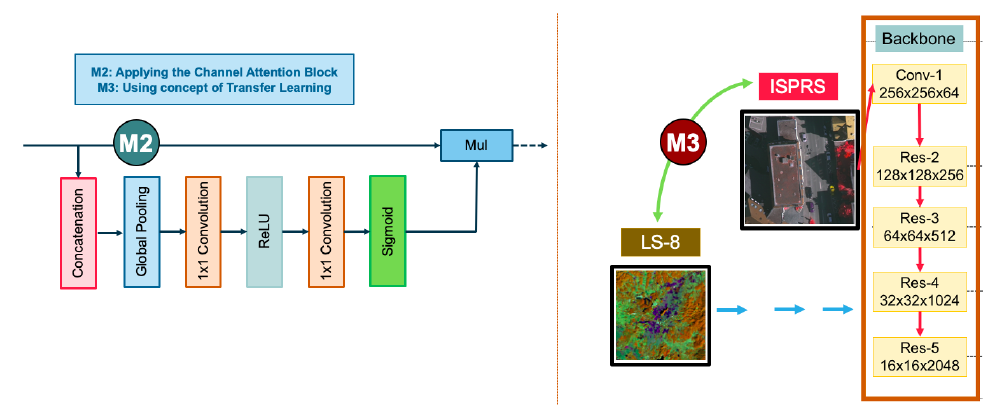
Figure 2. An Attention Mechanism (A) block (left) and the Transfer Learning (TL) approach (right) transfer knowledge (from pre-trained weights) across two corpora—medium and very high resolution images from